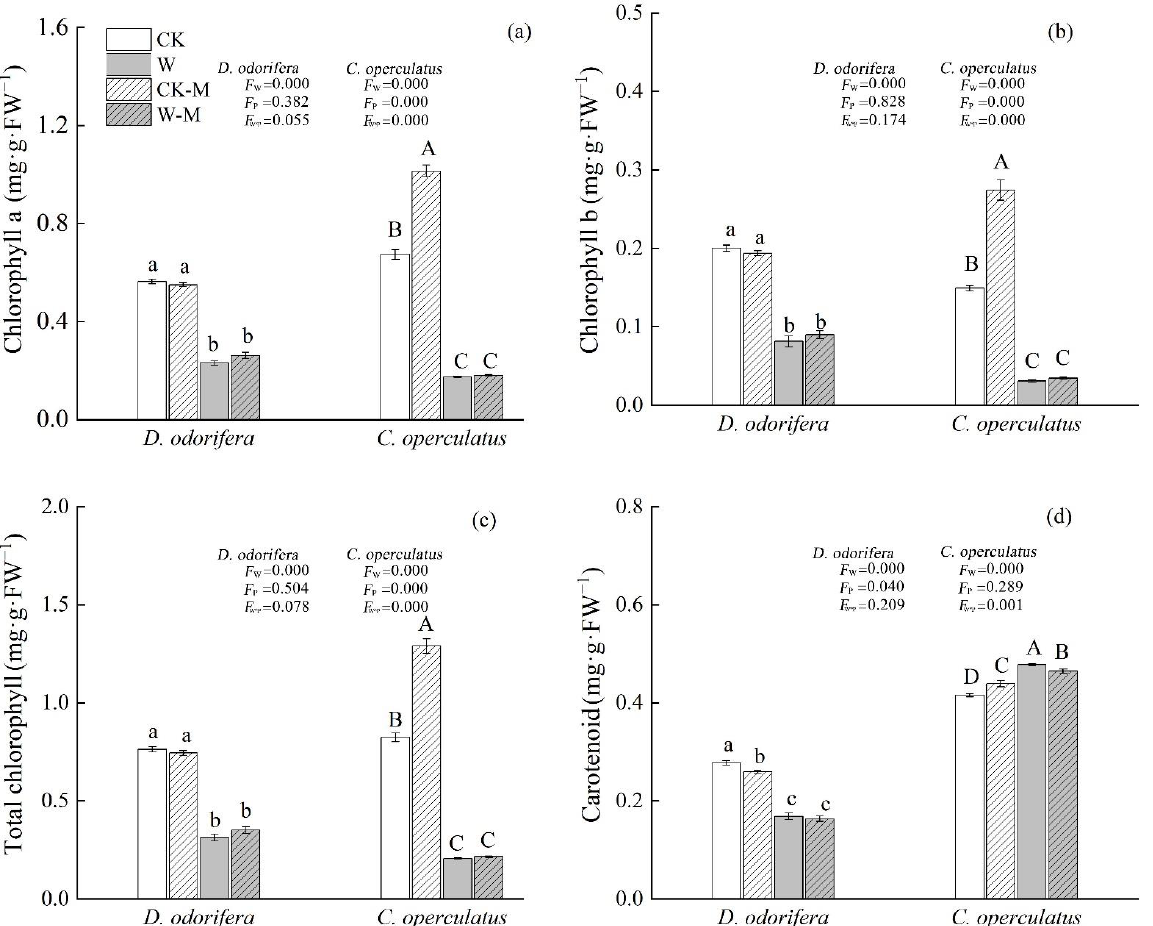
Figure 3. Comparative analyses of the content of chlorophyll a ( a ), chlorophyll b ( b ), total chloro- phyll ( c ), and carotenoid ( d ) of C. operculatus and D. odorifera under all treatments. Abbreviations, explanations of treatments, data descriptions, and statistics are the same as those shown in Figure 1.